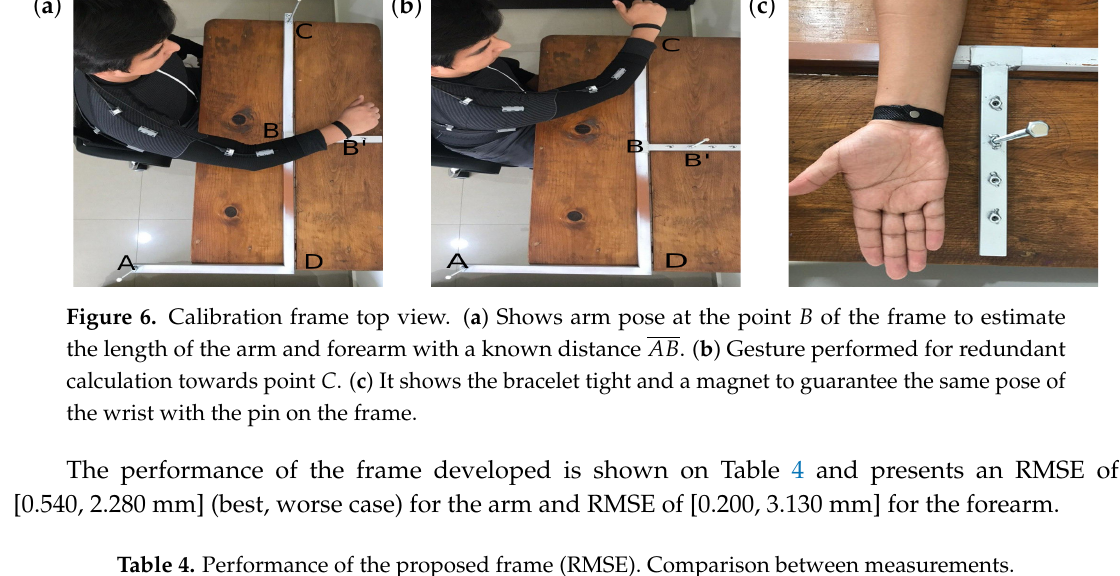
Table 4. Performance of the proposed frame (RMSE). Comparison between measurements. Tape vs.